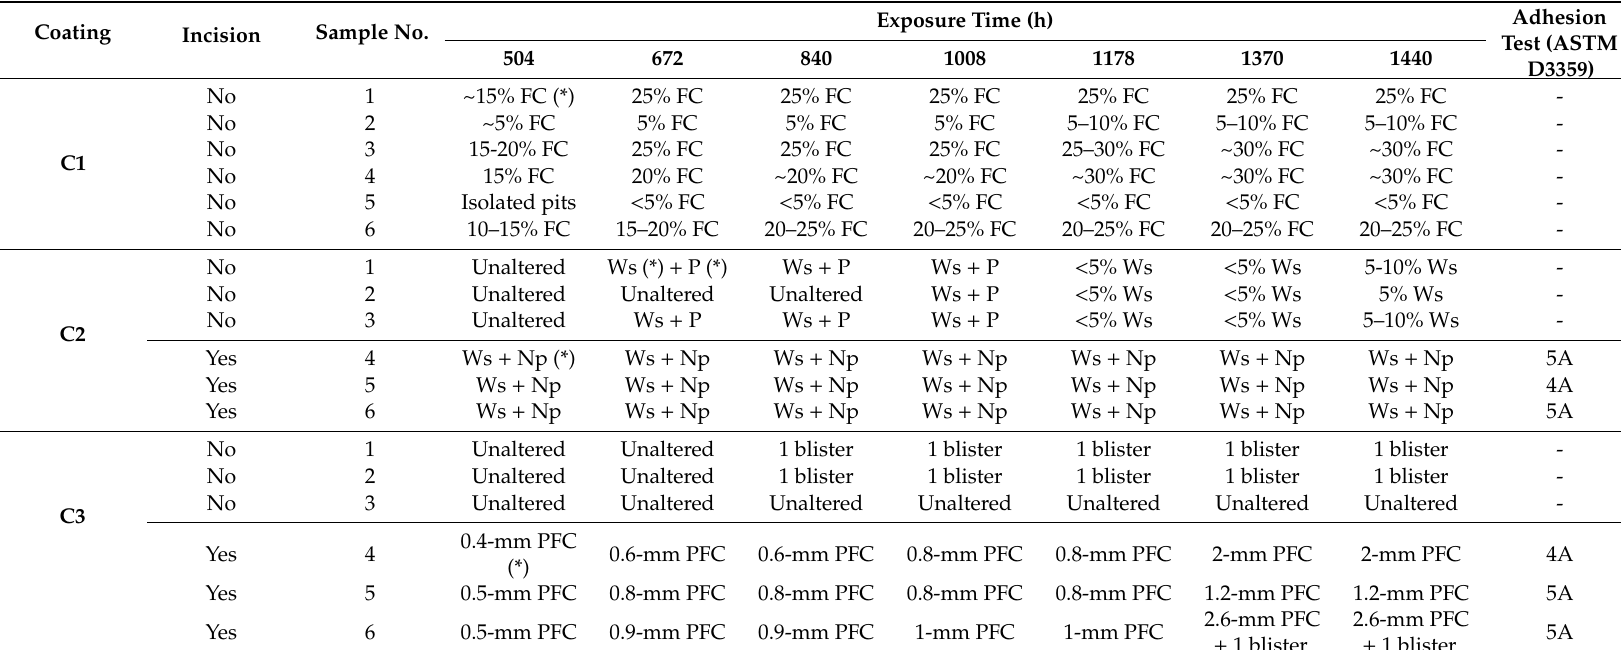
Table 6. Degradation observed in samples with the three coatings with and without incision at di ff erent evaluation times during exposure to a salt spray chamber (ISO 9227 [25]) and the adhesion test results of the samples with incisions (ASTM D3359